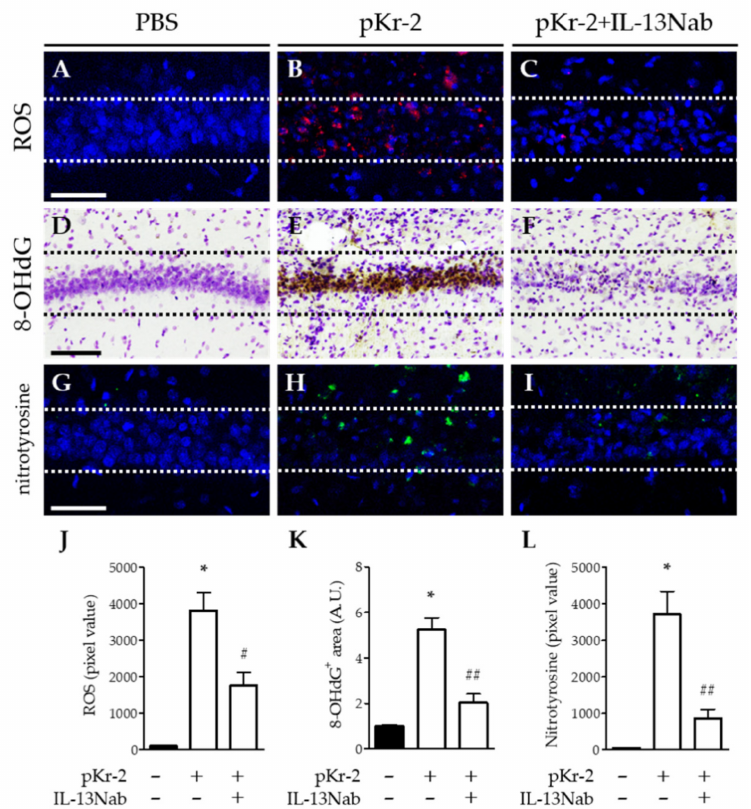
Figure 5. IL-13 modulates oxidative/nitrosative stress in the CA1 layer of pKr-2-injected hippocam- pus in vivo. Sections ( A , D , G ; PBS, B , E , H ; pKr-2, C , F , I ; pKr-2 + IL-13Nab) adjacent to those used in Figure 4 were processed for hydroethidine histochemistry or immunohistochemical staining. ( A – C ) Hydroethidine histochemistry to detect oxidant production (reactive oxygen species; ROS; red) in the CA1 layer of hippocampus. Nuclei were counterstained with DAPI (blue). Scale bar, 50 µ m. ( D – F ) 8-OHdG immunostaining with Nissl staining to detect oxidative DNA damages in the CA1 layer of hippocampus. Scale bar, 100 µ m. ( G – I ) Immunofluorescence images of nitrotyrosine immunostaining (green) to detect protein nitration in the CA1 layer of hippocampus. Nuclei were counterstained with DAPI (blue). Scale bar, 40 µ m. ( J ) Quantification of ROS expression. * p < 0.001, significantly different from PBS (control). # p < 0.05, significantly different from pKr-2. Mean ± SEM; n = 4 to 5 in each group, ANOVA and Newman-Keuls analysis. ( K ) Quantification of 8-OHdG expression. * p < 0.001, significantly different from PBS (control). ## p < 0.001, significantly differ- ent from pKr-2. Mean ± SEM; n = 4 to 5 in each group, ANOVA and Newman–Keuls analysis. ( L ) Quantification of nitrotyrosine expression. * p < 0.001, significantly different from PBS (control). ## p < 0.001, significantly different from pKr-2. Mean ± SEM; n = 4 in each group, ANOVA and Newman–Keuls analysis. Dotted lines indicate the CA1 layer of the hippocampus ( A – I